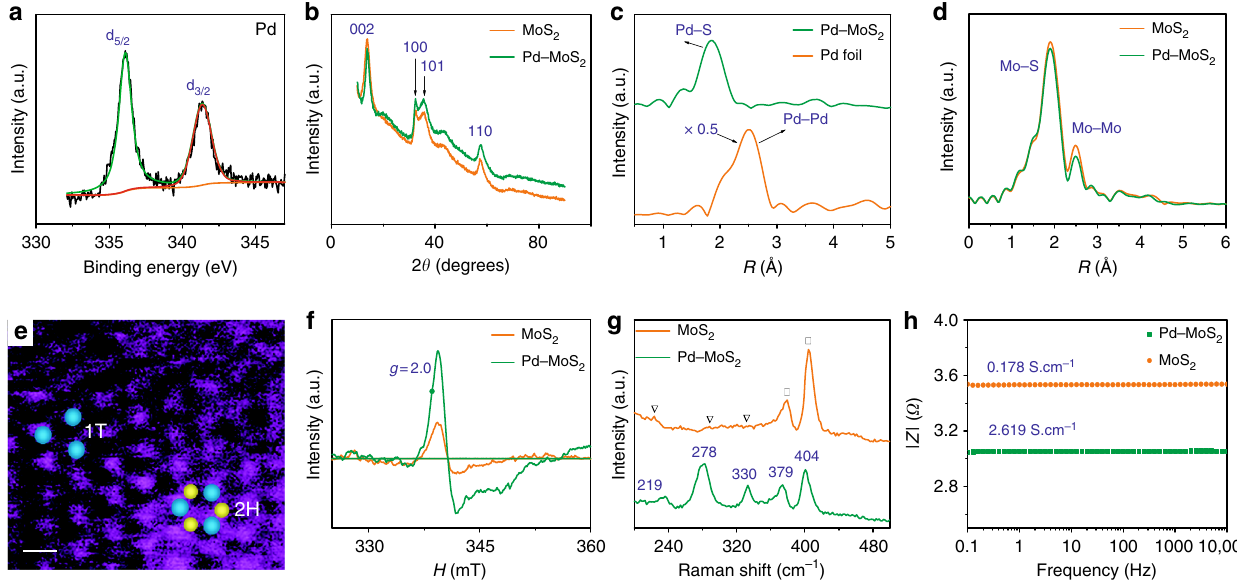
Fig. 2 Structural characterization of 1%Pd – MoS 2 and MoS 2 . a High-resolution XPS results (Pd 3 d region) of the 1%Pd – MoS 2 . b XRD patterns. c Fourier transform of the k 3 -weighted Pd K-edge of the EXAFS spectra. d Fourier transform of the k 3 -weighted Mo K-edge of the EXAFS spectra. e Dark- fi eld scanning transmission electron microscopy image of the 1%Pd – MoS 2 . Blue and yellow balls indicate Mo and S atoms, respectively. Scale bar: 1 nm. f ESR spectra. g Raman spectra of 1%Pd – MoS 2 and MoS 2 . h Bode spectra obtained through electrochemical impedance spectroscopy with a frequency range from 0.1 Hz to 10 kHz and amplitude of 5.0